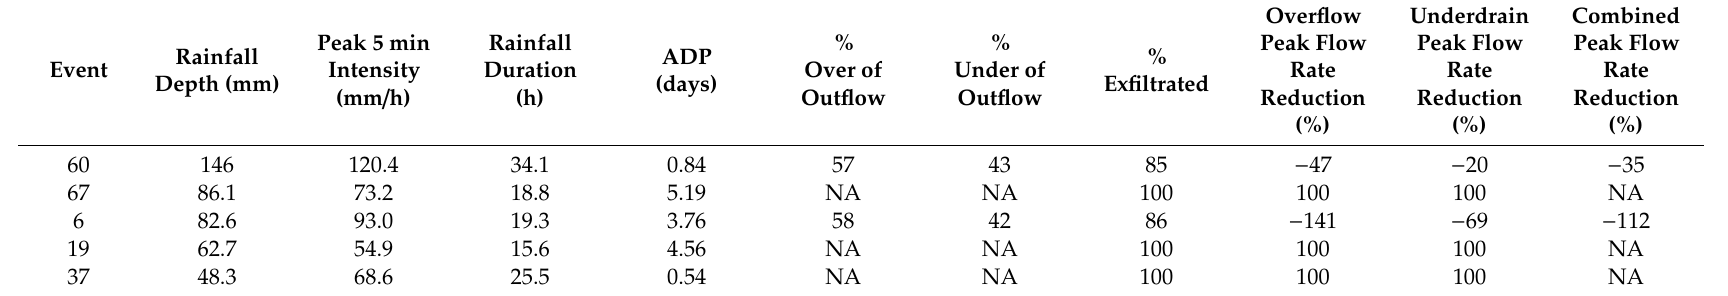
Table 7. Hydrologic performance of largest overall rainfall depth